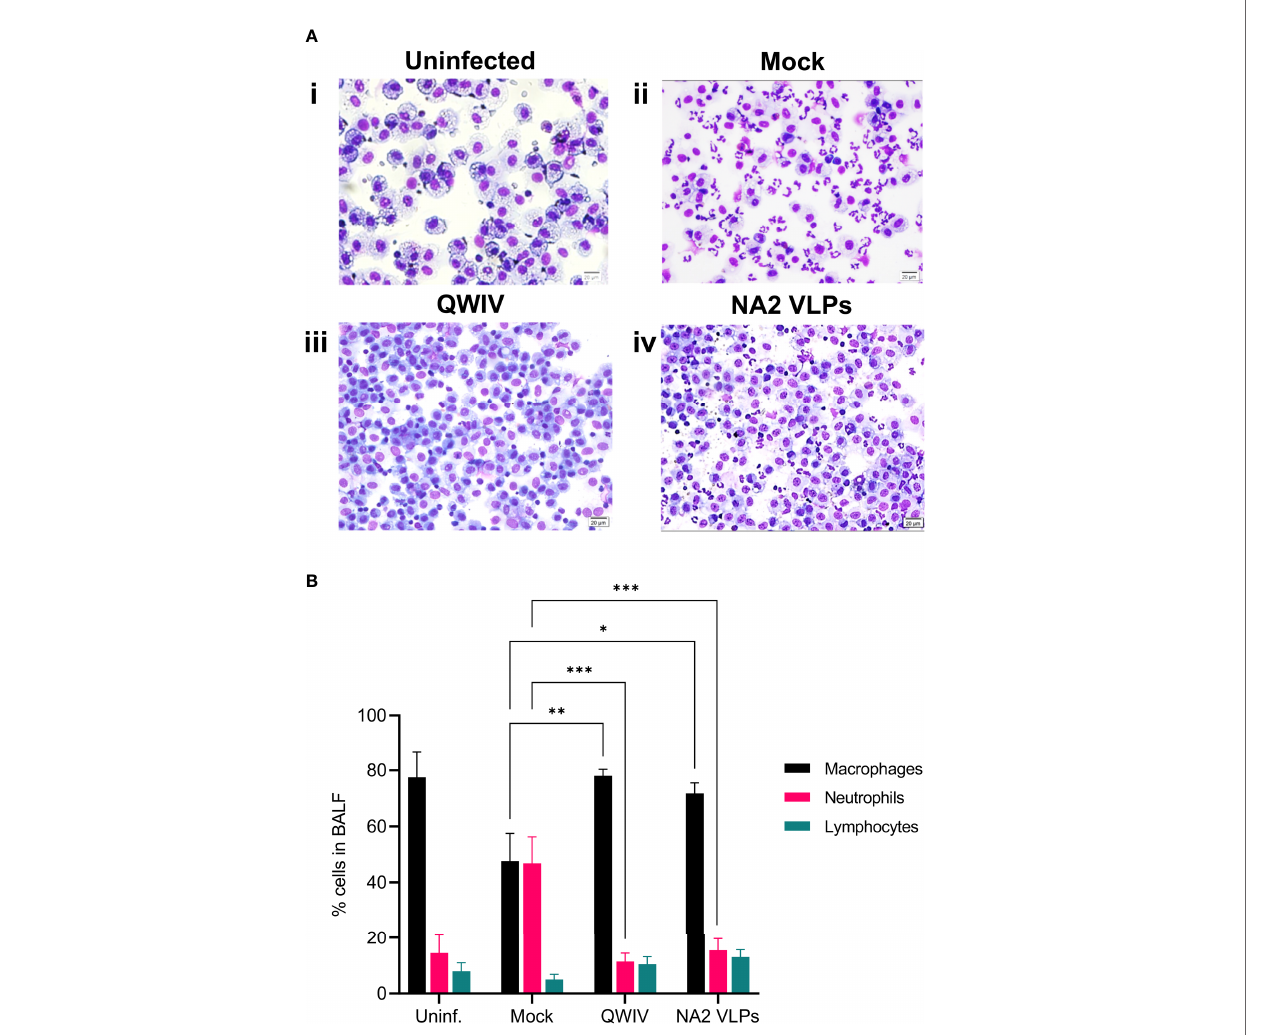
FIGURE 5 | Vaccination with NA2 VLPs and swine QWIV vaccine reduces neutrophilic in fi ltration in bronchoalveolar lavage fl uid collected from pig lungs post-infection. Bronchoalveolar lavage fl uid (BALF) was collected from lungs at necropsy 5 days post-infection. (A) Separated cells were added to slides and stained with Wright-Giemsa stain and differential cell counts were determined microscopically (i) uninfected unvaccinated group (ii) mock vaccinated group (iii) QWIV vaccine group (iv) NA2 VLPs vaccine group (20 m m scale bar, 40x magni fi cation) (B) Cell counts were expressed as a percentage of total cells. Black bars represent the mean percentage of macrophages, pink bars the mean percentage of neutrophils, and cyan bars represent the mean percentage of lymphocytes in each experimental group. Error bars represent the Standard Error of Mean (SEM). Statistical analysis was performed by two-way ANOVA test. * = p < 0.05; ** = p < 0.01; *** = p <